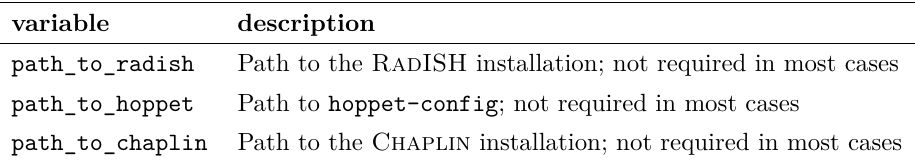
Table 2 . Additional parameters available the file MATRIX_configuration